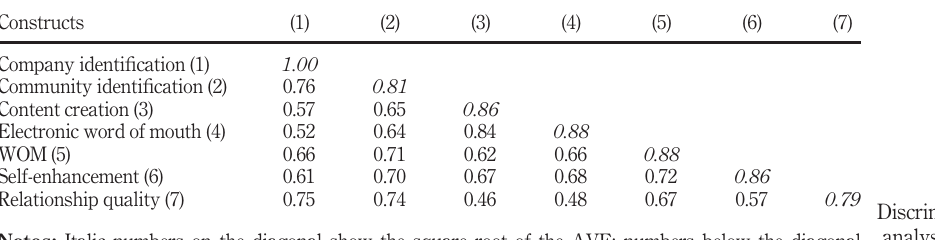
Table II. Discriminant